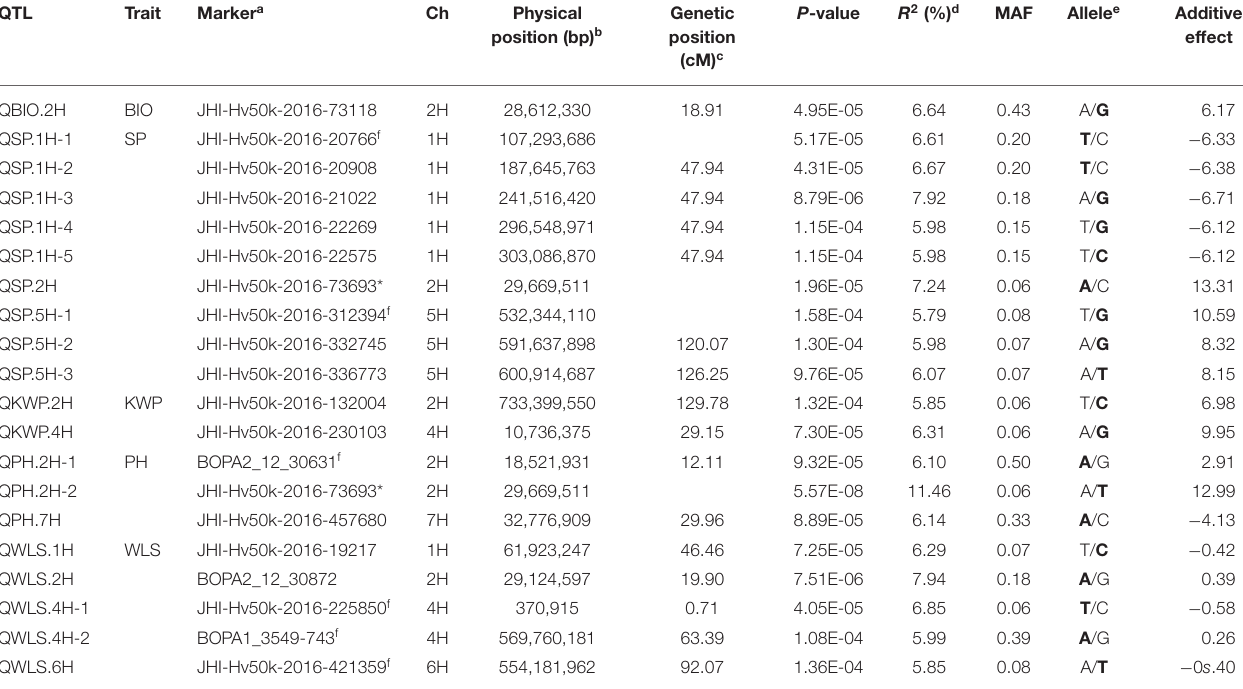
TABLE 5 | List of significant ( P < 1.6 × 10 − 4 ) marker-trait associations detected by GWAS using the MLM (Q + K) model in JMP Genomics and favorable alleles (bold) for assessed traits identified in the relative